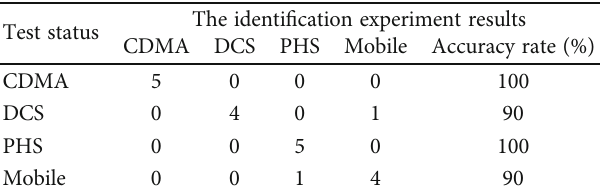
Table 2: Disturbance source signal characteristic identi fi cation results.